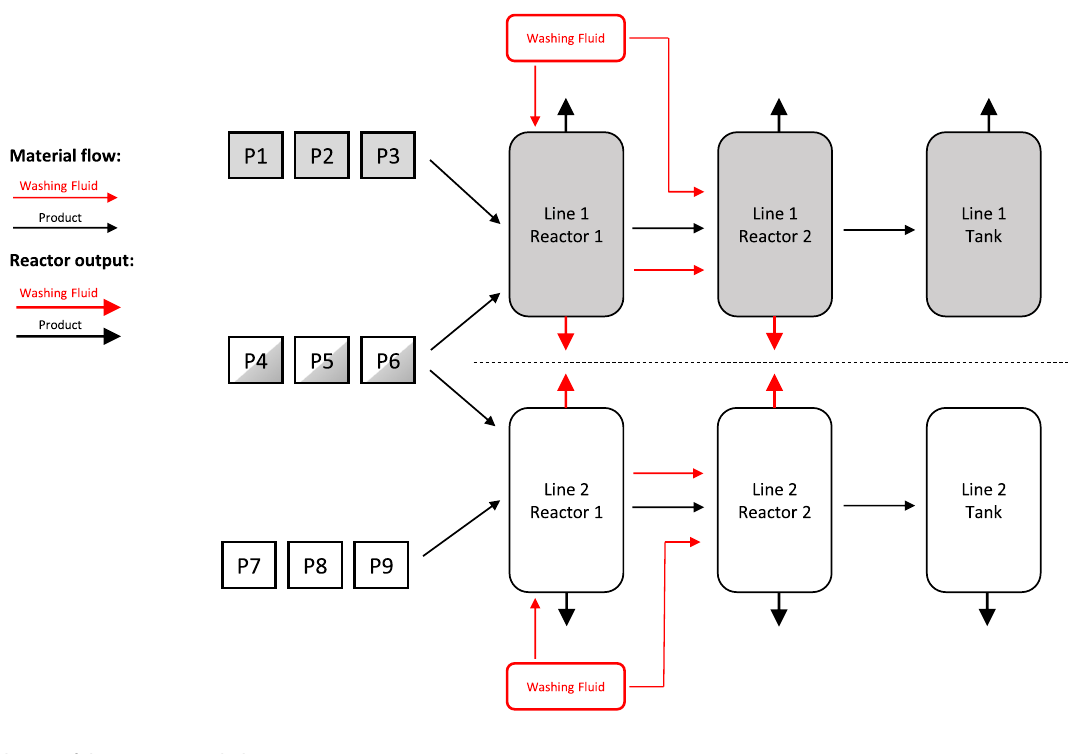
Fig. 1 Scheme of the investigated